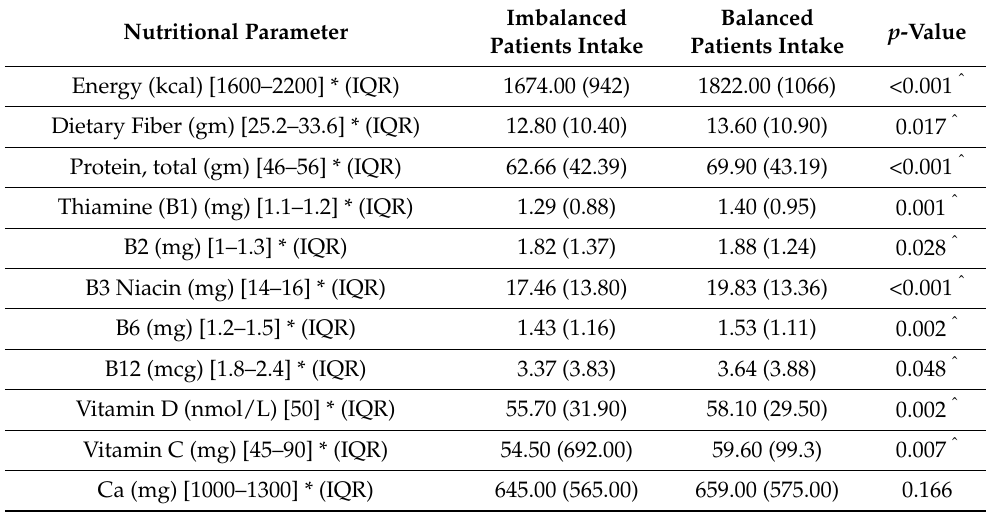
Table 3. Comparison of Median (IQR) nutritional intake between Imbalanced and Balanced